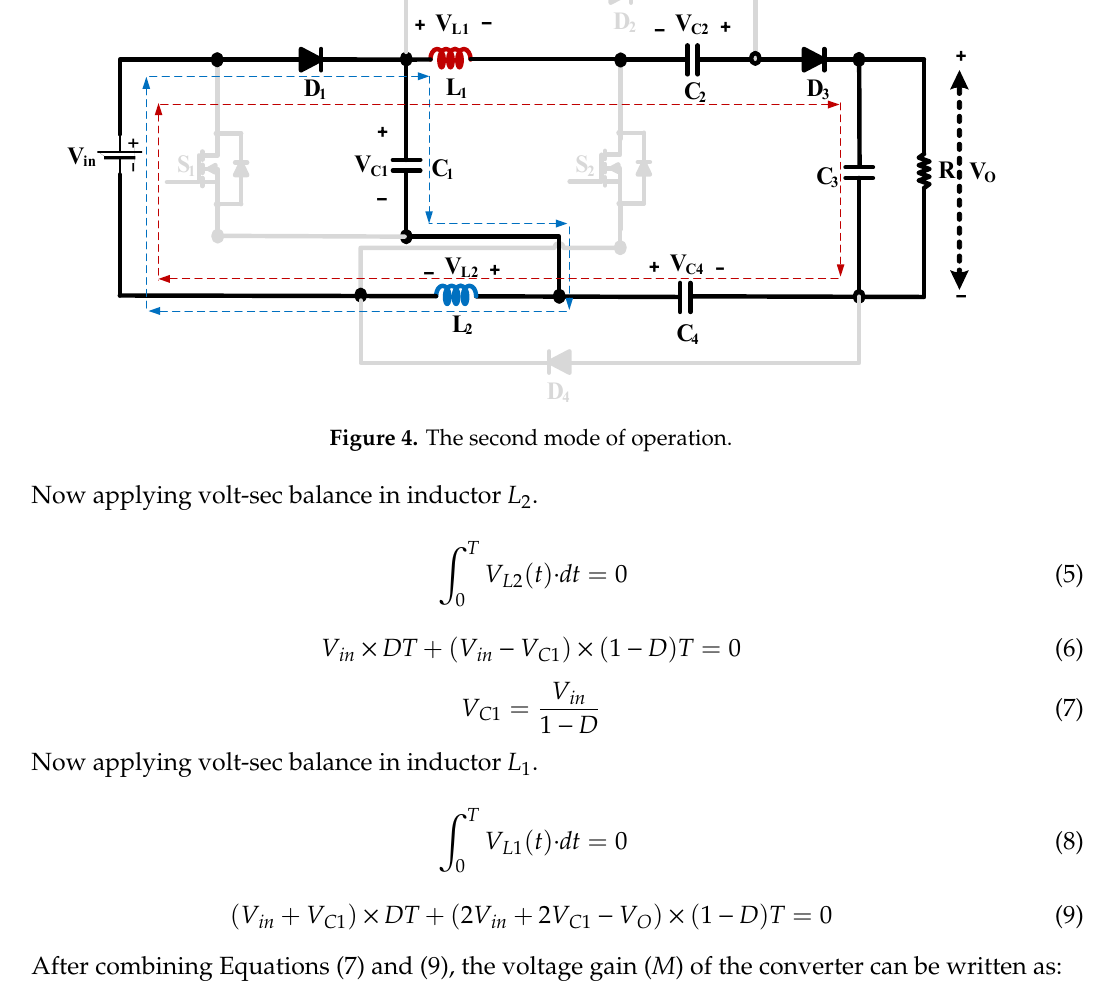
Figure 3. Related waveforms in continuous conduction mode (CCM).